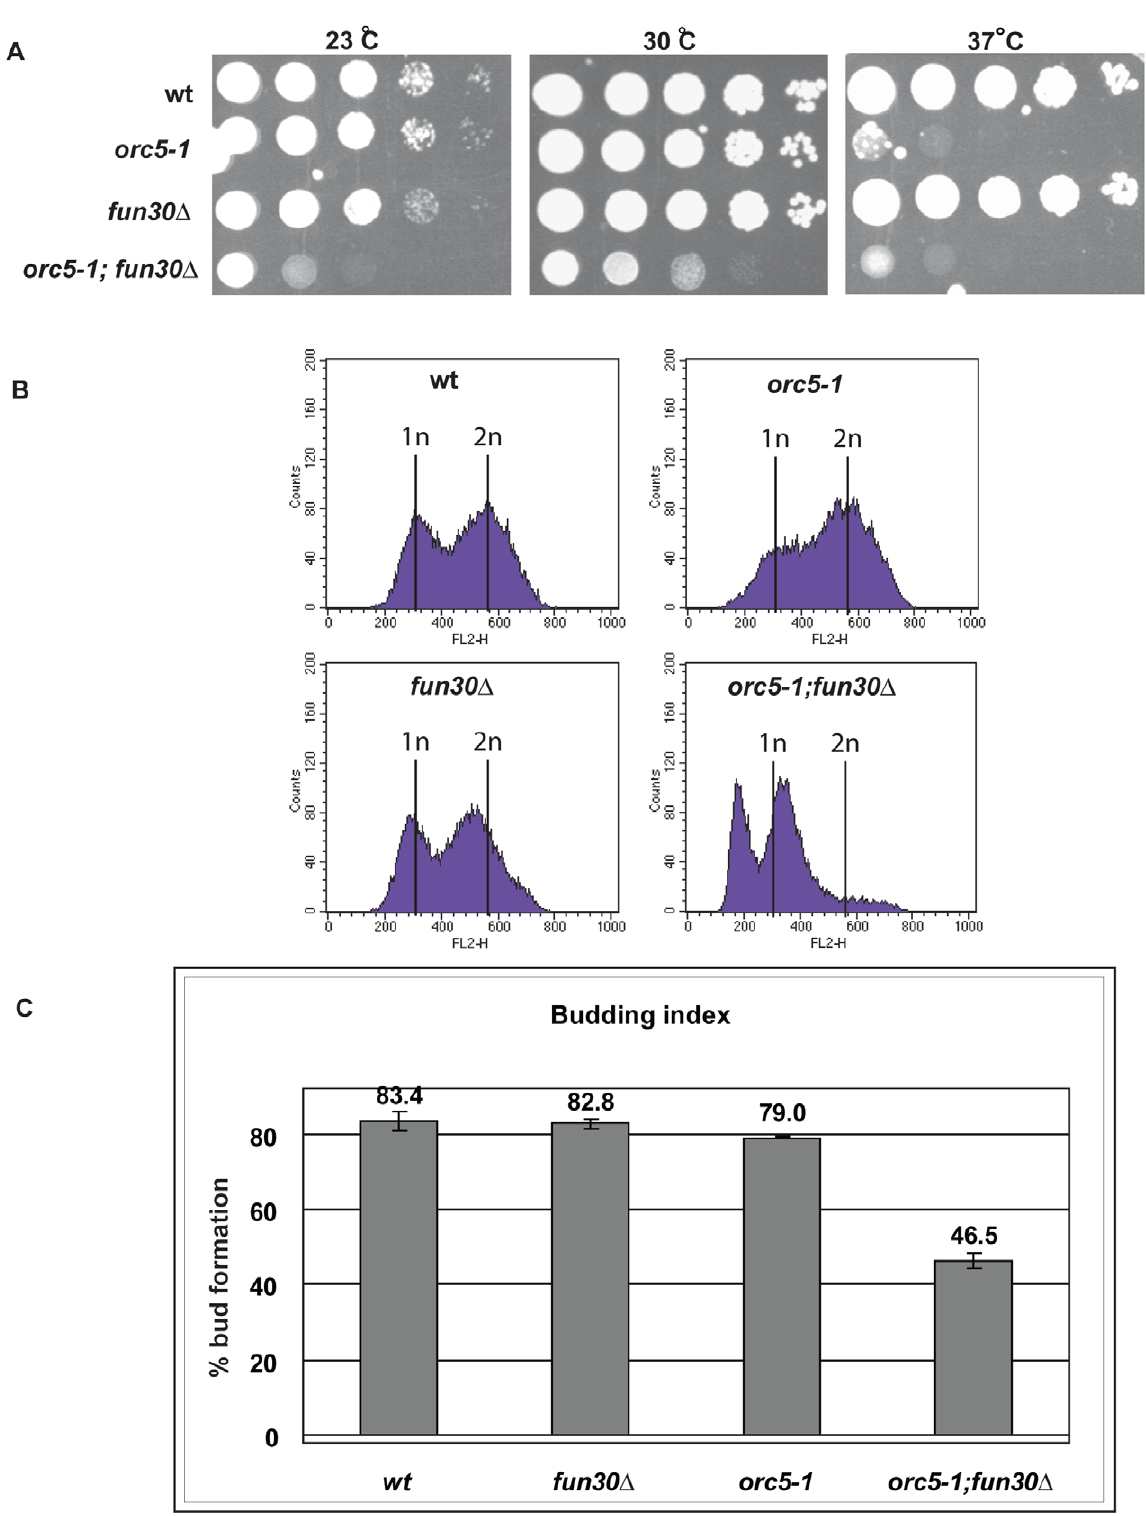
Figure 3. FUN30 interacts genetically with ORC in cell cycle progression. A. FUN30 was deleted in strains JRY7385 (wt) and JRY7459 ( orc5- 1 )[20]. The deletion and source strains were spotted onto rich medium (YPD) agar plates after a 10-fold serial dilution series and incubated for 2 days at the indicated temperatures. B. Flow cytometry profiles, measuring DNA content versus cell number, were determined for the strains described above. 1n and 2n indicates the cellular DNA content, unreplicated and replicated, respectively. C. The budding index of the strains described in A was determined as the percentage of cells with buds in an exponentially growing cell population in rich medium at 30 u C. The results are the average of three independent cultures for each strain and standard deviation.